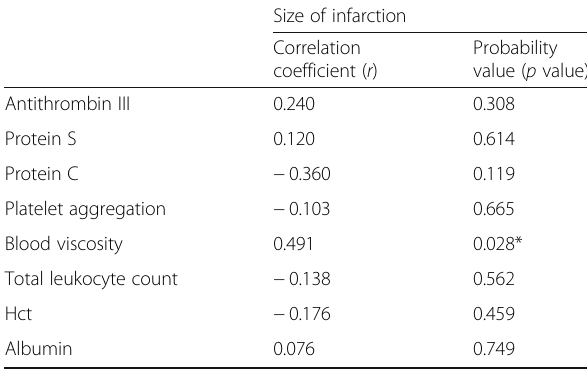
Table 3 Comparison between patients and control group regarding results of laboratory investigations